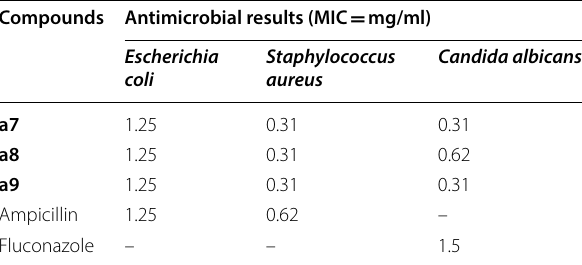
Table 6 Antifungal activity data of prepared compound